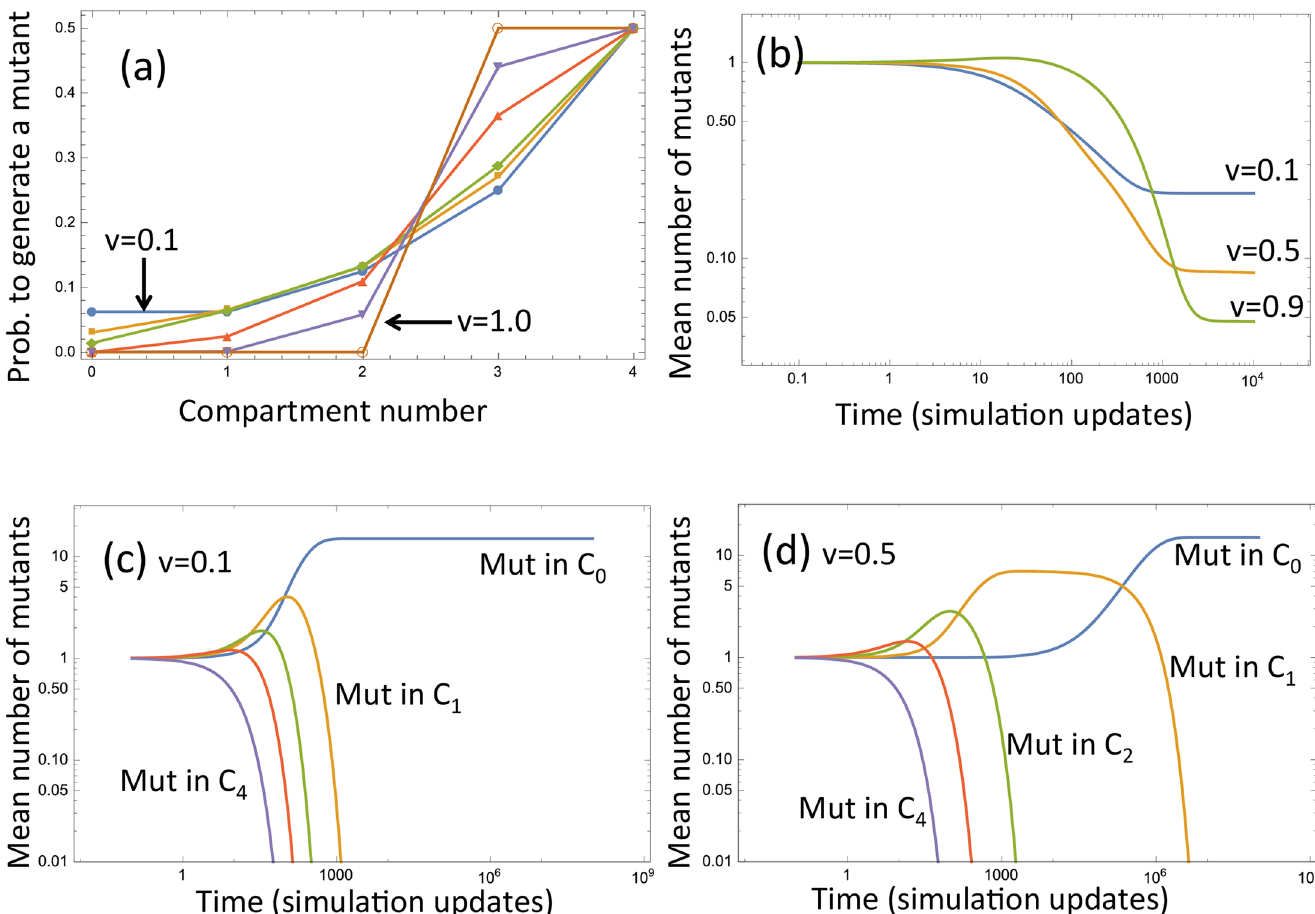
Fig 4. The role of the self-renewal rate on mutant generation and mutant dynamics (the analytical approach). (a) The probability of generating a mutant in each of the compartments for 6 different values of v : v = 0, 0.05, 0.1, 0.4, 0.7, 1. (b) The expected number of mutants produced from a single mutant cell in the absence of further de-novo mutations, plotted as a function of time for three different values of v . (c,d) The expected dynamics of mutants generated in different compartments at t = 0, in the absence of new mutations, for (c) v = 0.1 and (d) v = 0.5. Other parameters are: n = 4, and the compartment sizes are, from C 0 to C n : 40, 80, 120, 160,